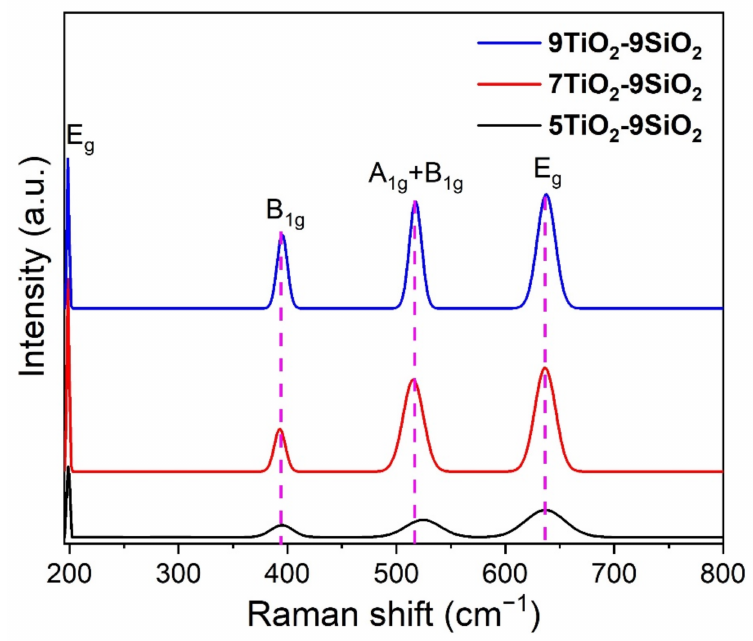
Figure 5. Raman spectrum of TiO 2 -SiO 2 thin films heated to 550 ◦ C in air